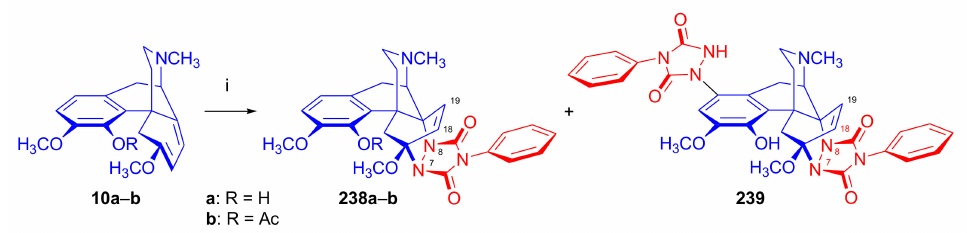
Figure 66. Reaction of opened E-ring morphinandienes with 4-phenyl-4 H -1,2,4-triazoline-3,5-dione. Reagents and conditions : (i): PTAD, acetone, room temperature, 90